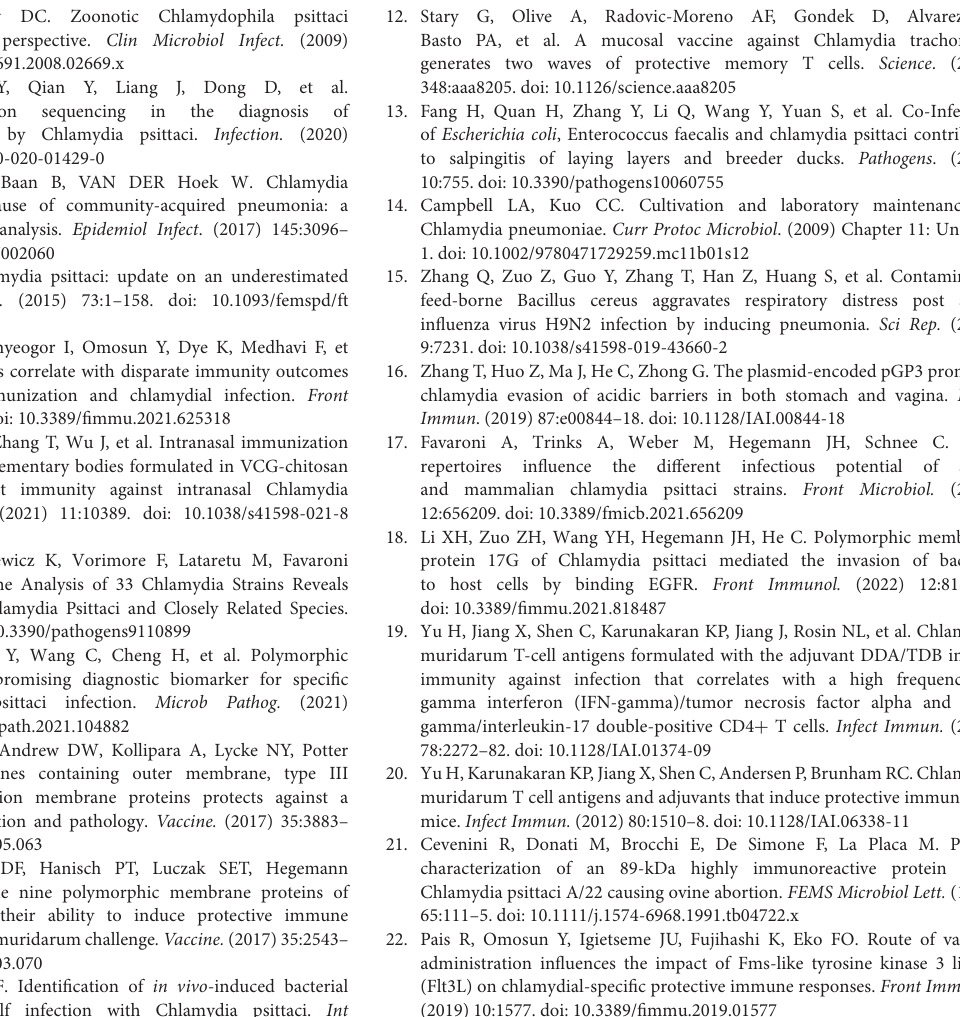
Supplementary Figure 1 | Pathological section of SPF chicken’s lung post Chlamydial challenge. (A) PmpGs + MOMP group: Less alveolar damage and hemorrhagic inflammation were observed in the alveolar cavity (arrow). (B) MOMP group: The focal intra-alveolar hemorrhagic lesions were observed and whole alveolar structures were well protected post infection (arrow). (C) PmpGs group: Scattered hemorrhage was observed in the alveolar septa and mild interstitial lesions were observed in the lungs (arrow). (D) Control group: Typical hyaline membrane formation in alveolar space and exudative fluid containing fibrin and epithelial cells in alveolar walls were observed. Also, severe interstitial lesions were observed in the lungs due to inflammatory infiltrates (arrow). Hematoxylin & Eosin staining (Magnification